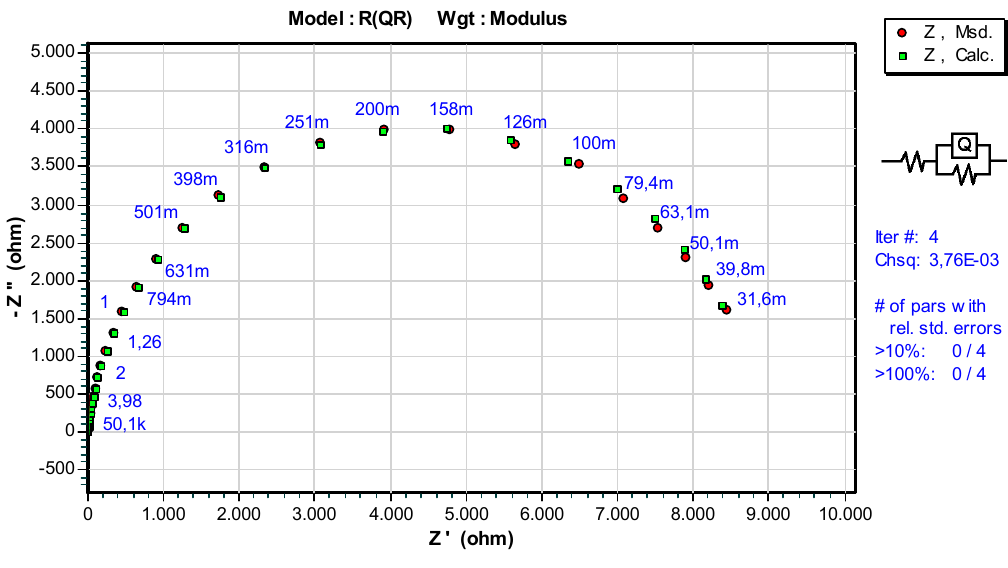
Figure 7. Nyquist plot of WC-11 Ni-a.